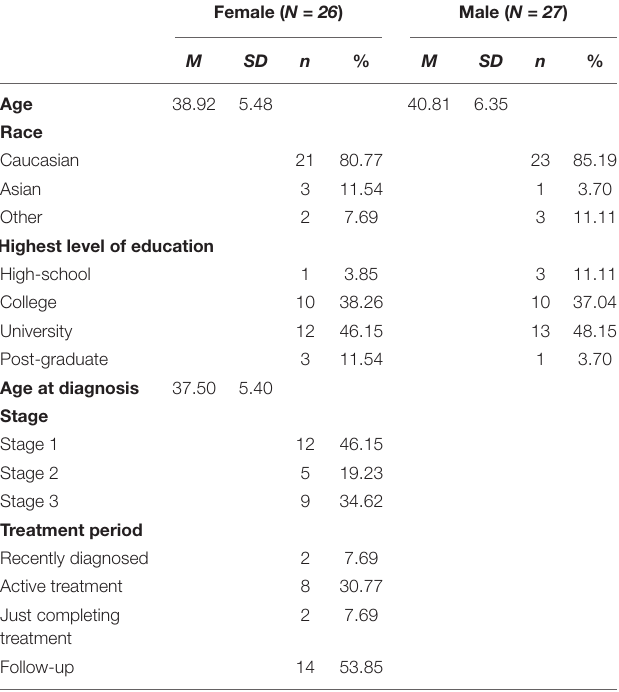
TABLE 1 | Individual Participant Characteristics ( N = 53 participants).